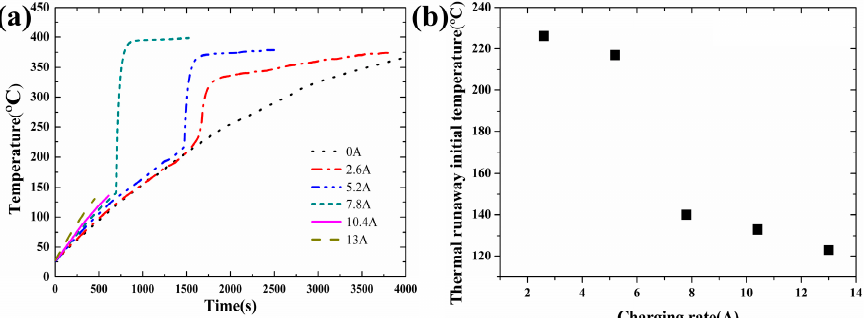
Figure 6. Temperature curves and thermal runaway initial temperature of lithium-ion battery under different charging rates: ( a ) Temperature curves; ( b ) Thermal runaway initial temperature.